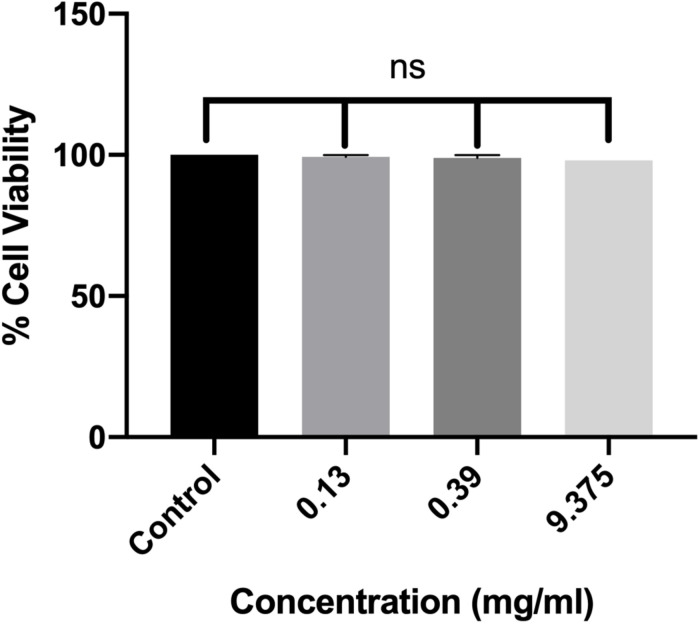
Dose-dependent effect of RMA46 ethyl acetate extract on the cell viability. Experiments were performed in triplicates, and difference in mean values was compared with that of the untreated experiment control. One-way ANOVA was used for multiple comparison analyses. ns denotes not significant.